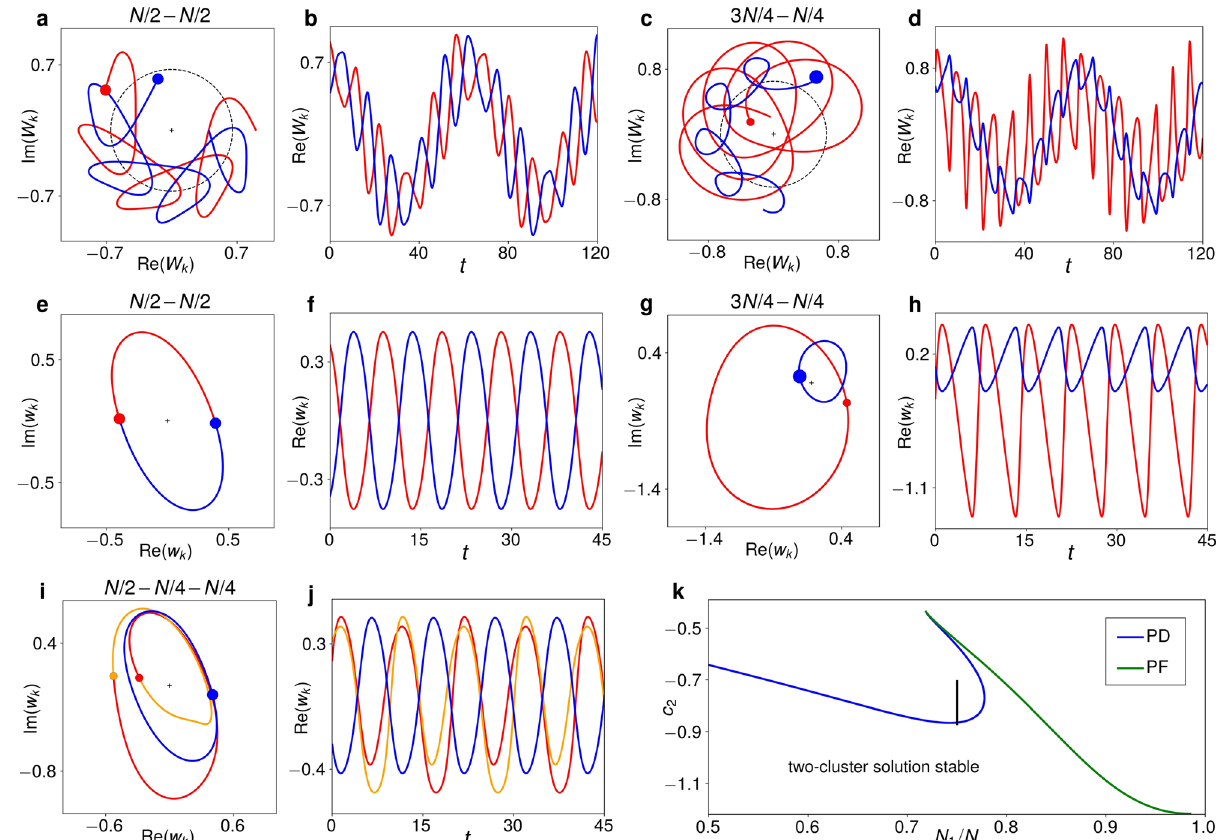
Fig. 1 Two-cluster solutions and their bifurcations. Each fi lled circle refers to the instantaneous position of a cluster, the line of the respective same colour to its trajectory. a Trajectory of an N /2 − N /2 modulated-amplitude cluster solution for c 2 = − 0.71 and η = 0.65. b Time series of the real part of each oscillator in a . c , d Like a , b for an unbalanced 3 N /4 − N /4 solution at c 2 = − 1.0 and η = 0.65. e – h The solutions in a , b and c , d , respectively, when viewed in a frame co-rotating with the ensemble average 〈 W 〉 = η e − i ν t . For the N /2 − N /2 solution, the two clusters follow the same trajectory. i , j N /2 − N /4 − N /4 three-cluster solution at c 2 = − 0.69, emerging from the solution in a , b in a period-doubling bifurcation. k Bifurcations destabilizing the two-cluster solution as a function of c 2 and the relative size of the larger cluster N 1 / N for η = 0.67. The blue line denotes a period-doubling (PD) that splits the smaller cluster, and the green line a subcritical pitchfork (PF) that blows it up. The vertical black line marks the c 2 -incremented simulation in Fig.